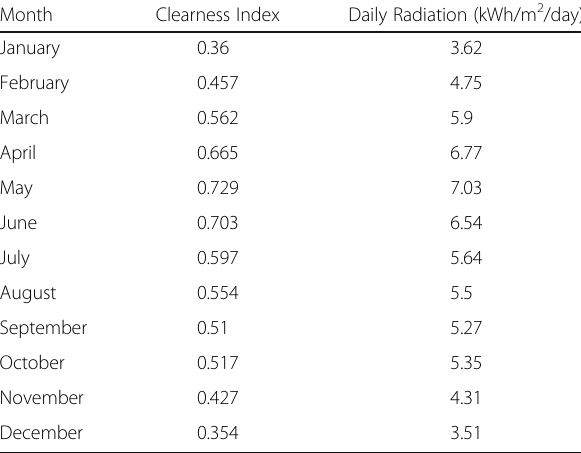
Table 3 Monthly average solar global horizontal irradiance